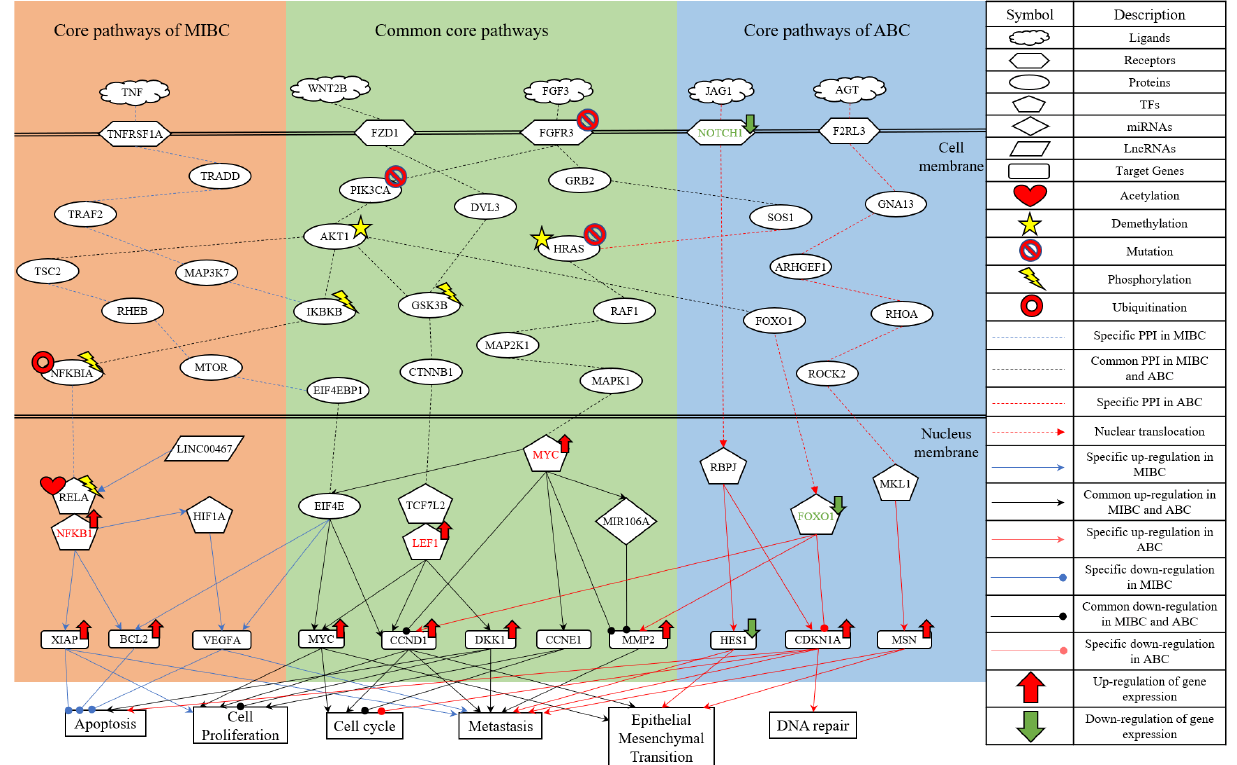
Figure 2. The common and specific core signaling pathways and their downstream cellular dysfunc- tions between MIBC and ABC. The figure shows the genetic and epigenetic carcinogenic mechanisms of MIBC and ABC. The orange background contains the specific core signaling pathways of MIBC. The green background contains the overlapping core signaling pathways between MIBC and ABC (i.e., common core signaling pathways). The blue background contains the specific core signaling pathways of ABC. The gene symbols in red or green font denote the selected significant biomarkers as drug targets.